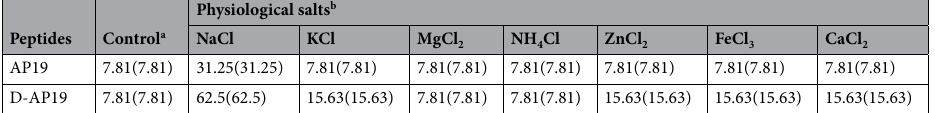
Peptides Control